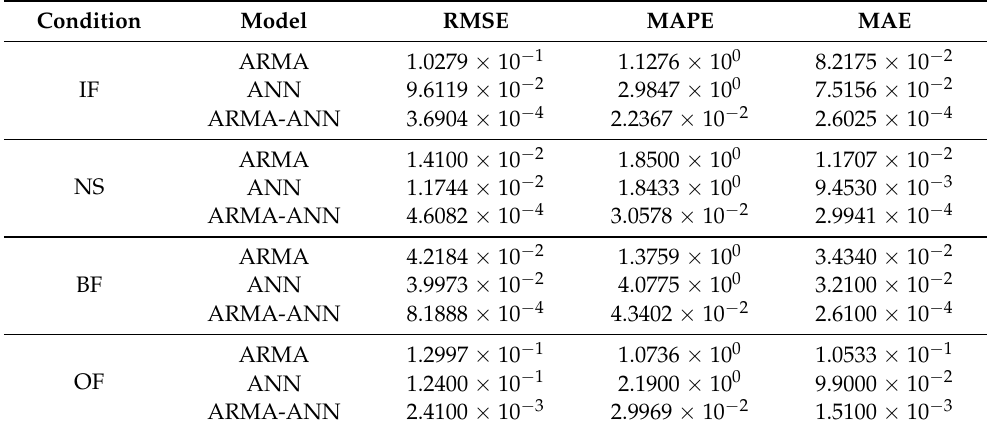
Table 3. Comparison of performance criteria of three models for all dataset